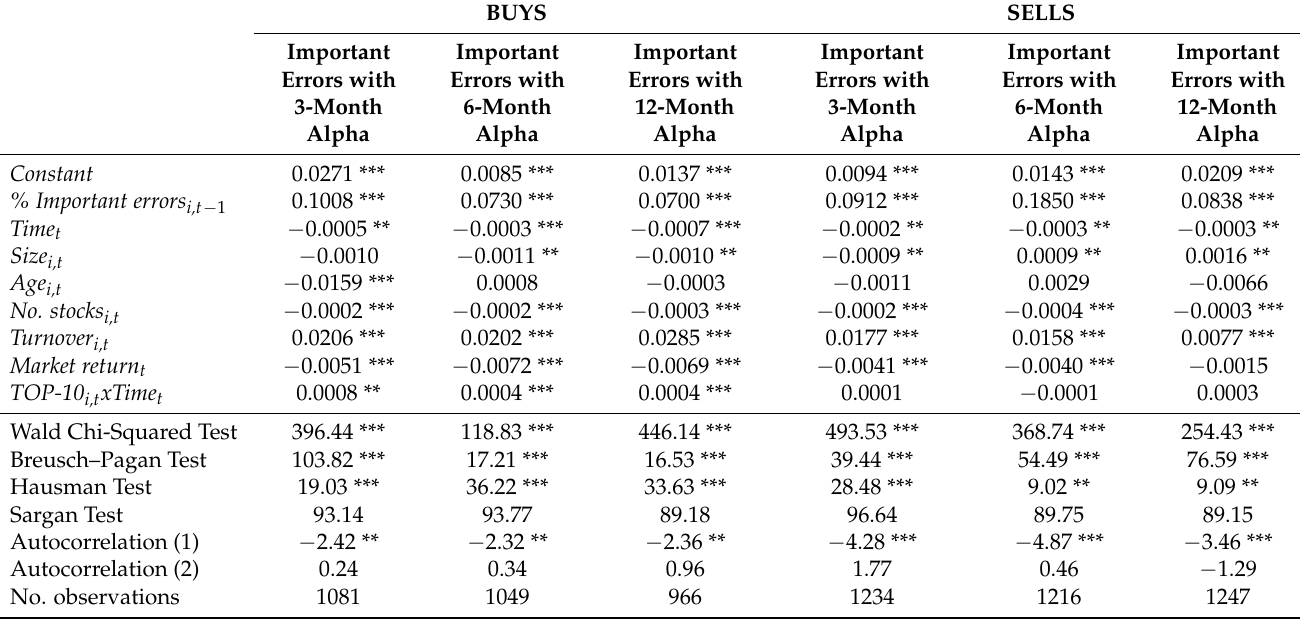
Table 6. Learning results by fund family size (Euro domestic equity mutual funds). This